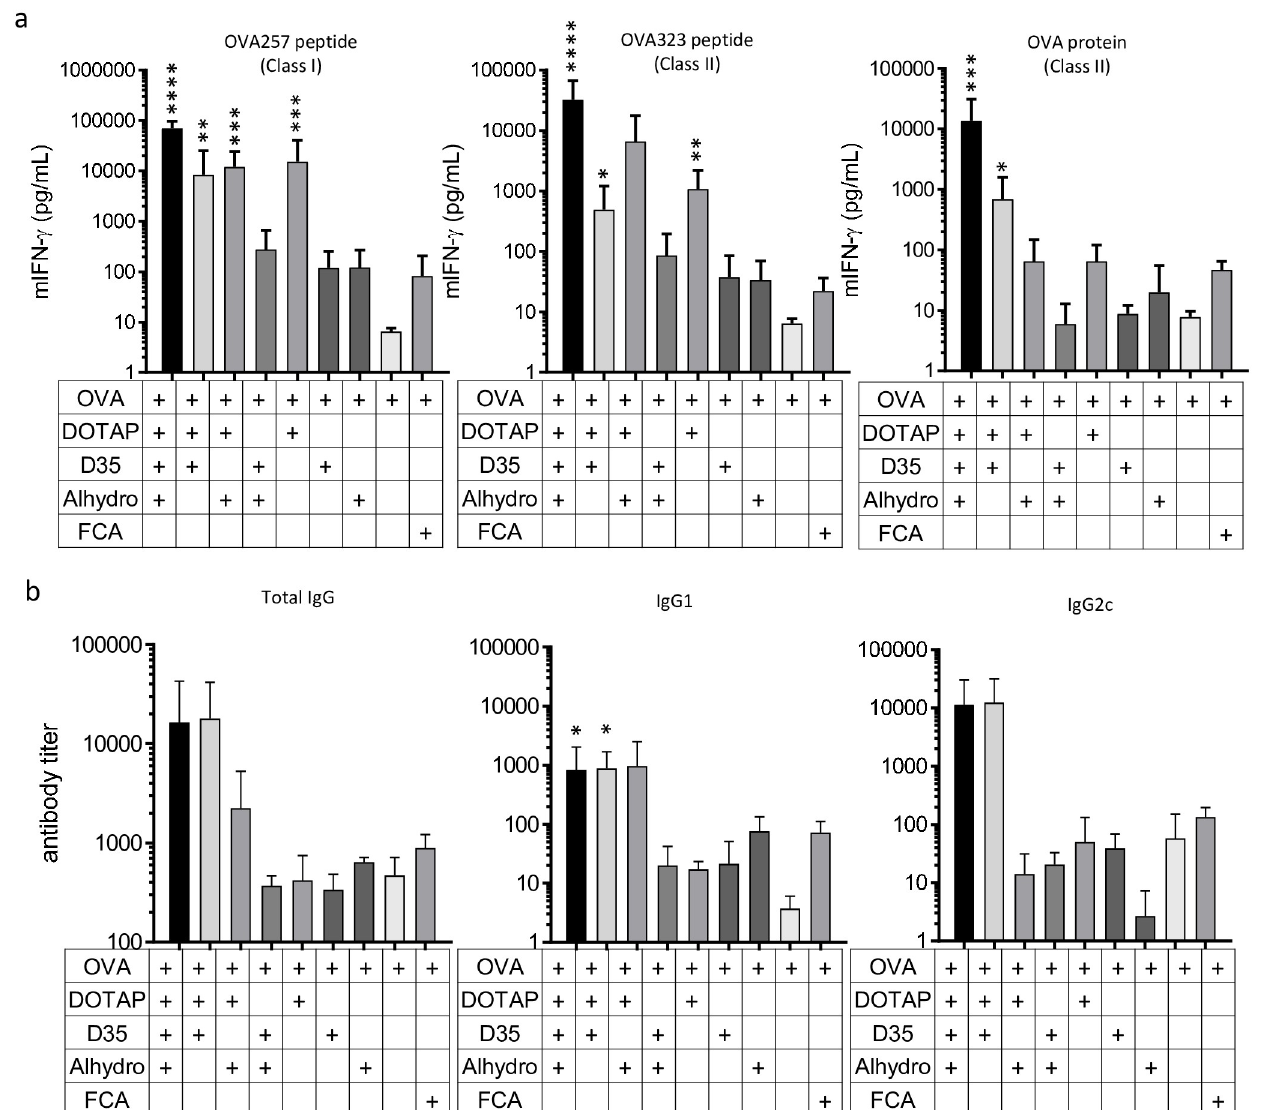
Fig 1. OVA/DOTAP/D35/Alhydrogel immunization induces strong T cell and antibody responses. C57BL/6J mice were immunized i.d. with OVA and the indicated adjuvant combinations at the tail base. OVA (10 μ g), DOTAP (100 μ g), D35 (10 μ g), and Alhydrogel (40 μ g) were mixed in a 1:1 mixture of 5% glucose and phosphate-buffered saline (PBS)(Glu/PBS buffer). After 7 days of immunization, splenocytes and serum were collected. The splenocytes were stimulated in vitro with OVA257-264 peptide that induces MHC class I restricted response (CD8 + T cell response), OVA323-339 peptide, or OVA protein that induces MHC class II restricted response (CD4 + T cell response). (a) After 24 h, the concentration of mouse IFN- γ in the culture supernatant was measured by ELISA. (b) The OVA-specific antibody titers of total IgG, IgG1, and IgG2c were determined by ELISA after 7 days of the single immunization. The bar graph indicates the mean + SD of cytokine concentration observed in six mice per group (a) and antibody titer calculated from three mice per group (b). Statistical significance compared with OVA only is shown by asterisks in the bar graph; � p < 0.05, �� p < 0.01, ��� p < 0.001, ���� p < 0.0001.